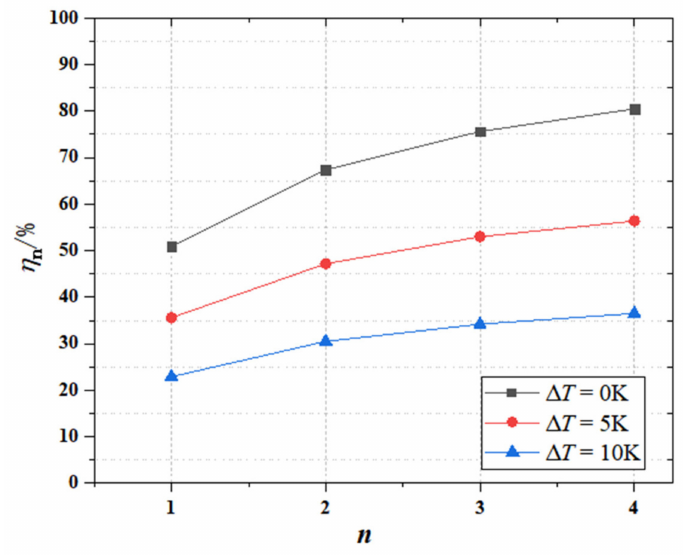
Figure 2. Exergy efficiency of the thermal fluid, η n /%.